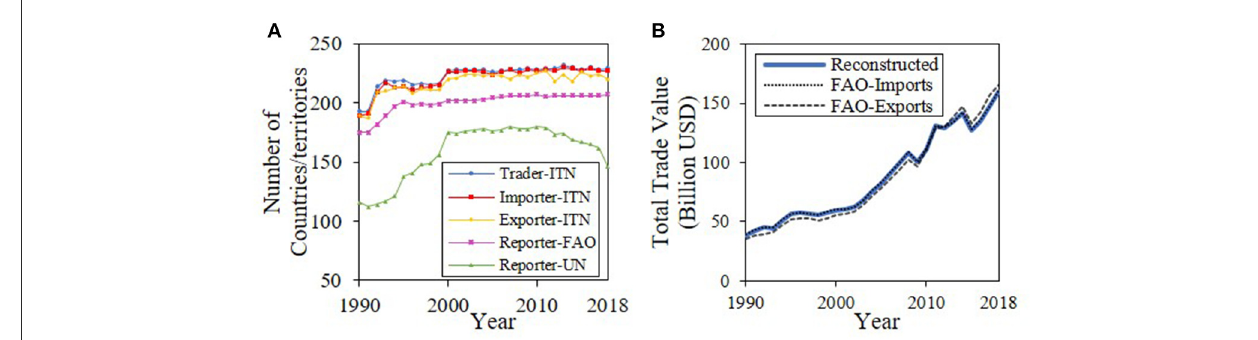
FIGURE1 The validation of reconstructed bilateral trade flows. (A) Comparison of the total values of reconstructed bilateral trade flows with the values of total fish imports and exports from FAO’s Fishstat database. (B) Comparison of the numbers of traders, importers, and exporters identified by ITN-Fish with the numbers of traders recorded in the Fishstat database and reporters recorded in the UN Comtrade